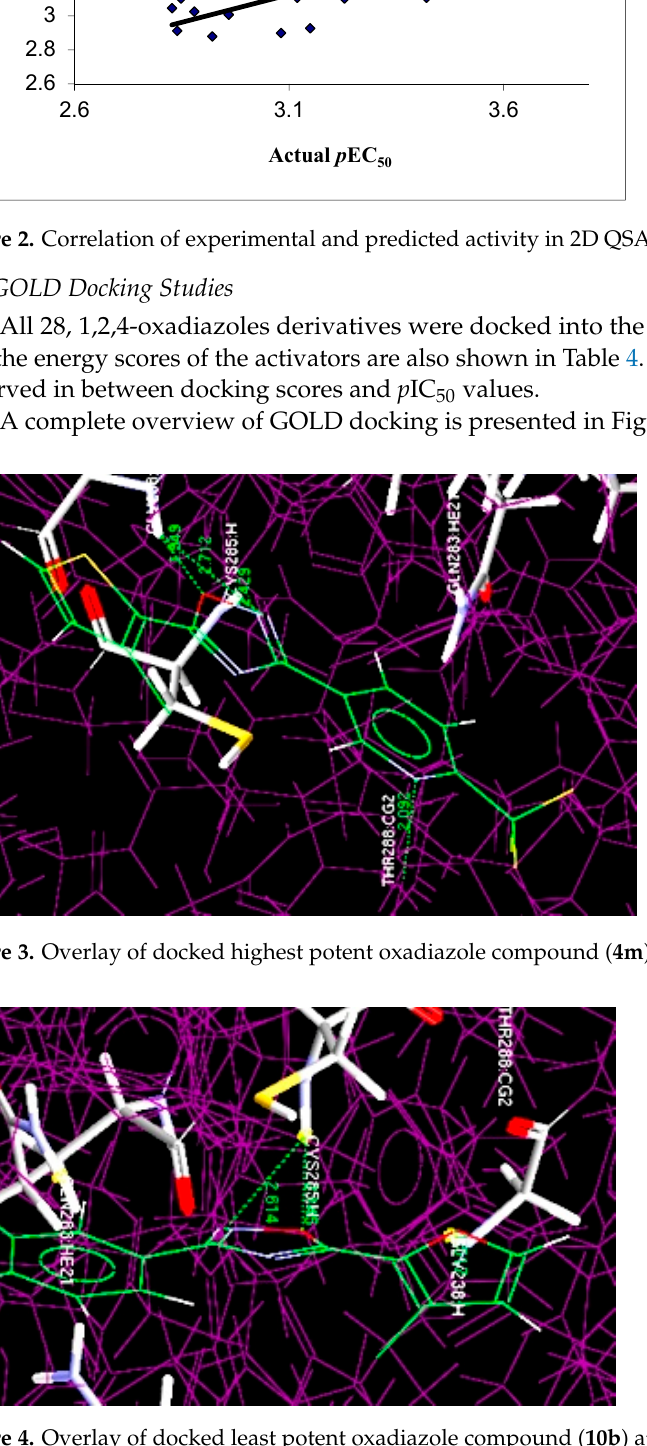
Figure 4. Overlay of docked least potent oxadiazole compound ( 10b ) at the active site of 1RE1. The docking results revealed that most active compound 4m is properly located at the binding site of the Cys205 and Gly238 amino acid residues and numerous interactions occur between it and the binding region of the enzyme. The four key hydrogen bond